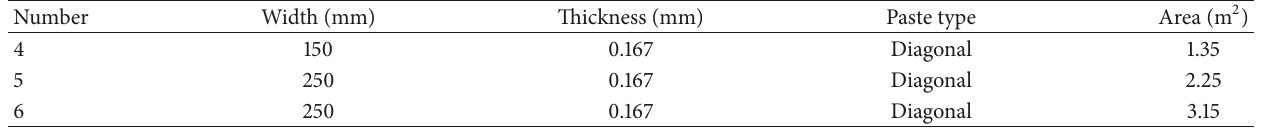
Figure 10: Stress contours of impacted walls at 𝑇 = 300 ms: (a) model 1, (b) model 2, and (c) model 3. Table 5: Scheme of reinforcement at different FRP